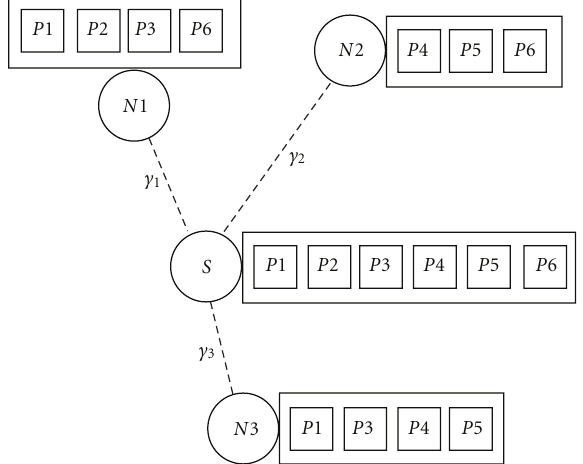
Figure 12: In the setup the three sinks have three distinct subsets of packets in S ’s bu ff er and channels from S to each of the sinks have a di ff erent SNR.